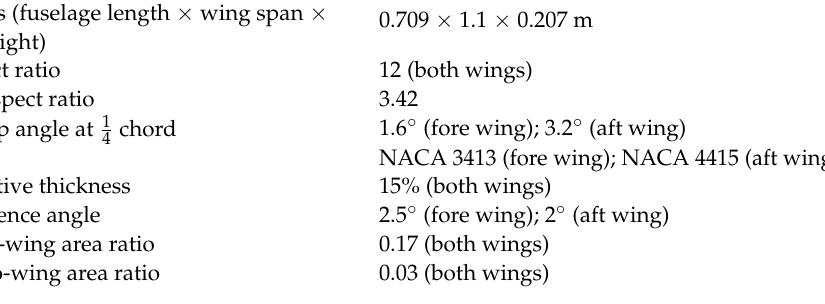
Figure 2. Models with tufts for flow visualization in T-1 wind tunnel 2.25 × 3 m test section ( a ) with an idle duct and ( b ) with vertical fishtail surfaces.